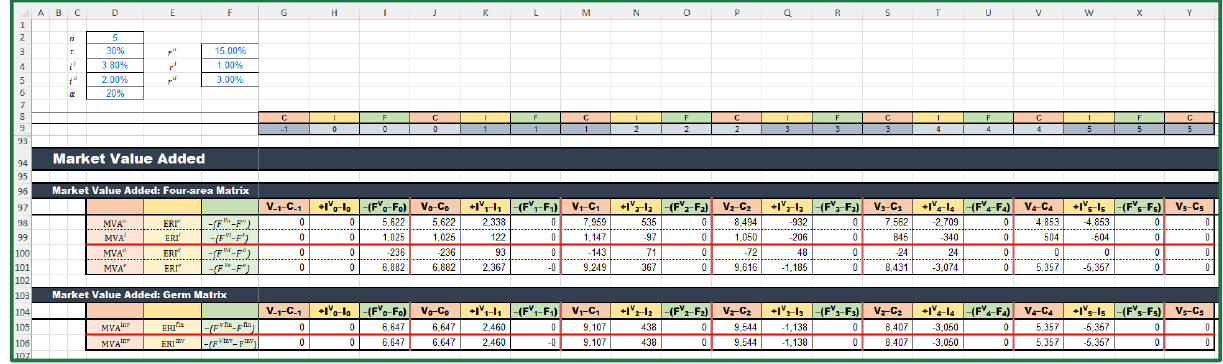
Figure 35. Market value added: four-area matrix and germ matrix (“SplitScreenStrip”